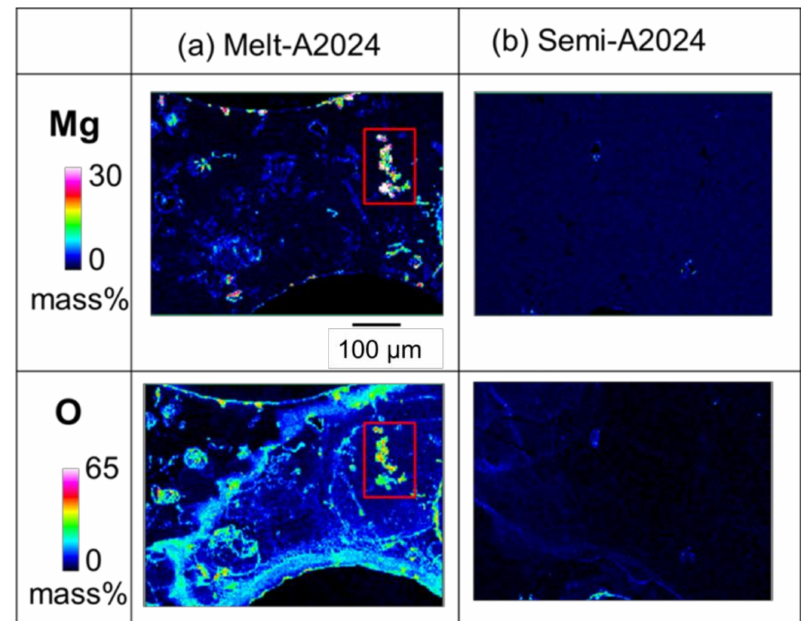
Figure 10. X-ray elemental mapping of Mg and O in cell wall obtained by electron probe micro analysis (EPMA): ( a ) Melt-A2024; ( b )